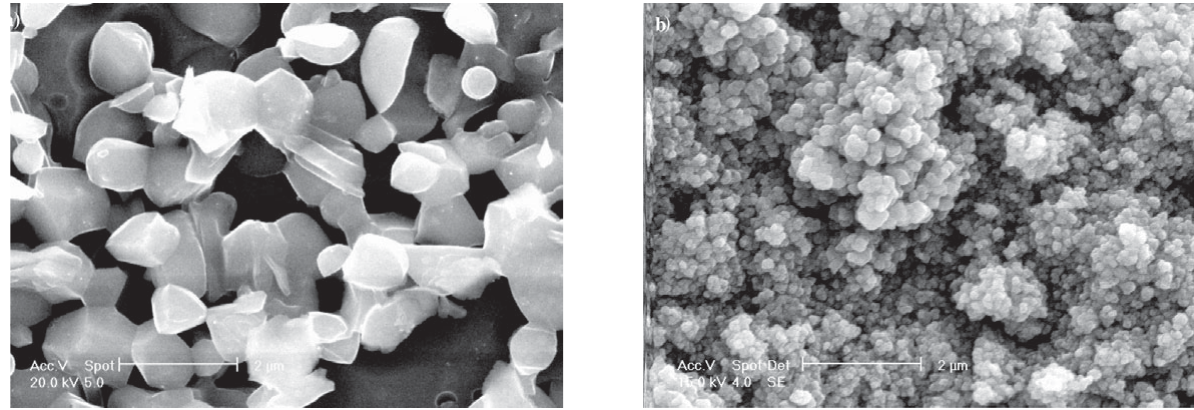
Figure 5 . Ti Al-TiC composite fabricated through MA and HIPing: a) etched, shows the TiC particles; b) shows the formation of fine oxides. 3